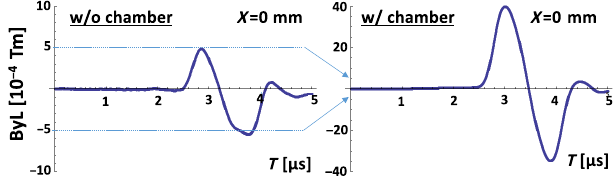
FIG. 7. Eddy-current effects of the magnet, as observed without a chamber installed in the bore. The left-hand figure shows the eddy-current signal of the magnet in the absence of the chamber. The right-hand figure shows the eddy-current signal, including eddy currents from the magnet and the chamber coating, in the presence of the chamber. Notably, the pulse width of the eddy- current signal in the absence of the chamber was shortened to 1 . 6 μ s from 1 . 8 μ s in the presence of the